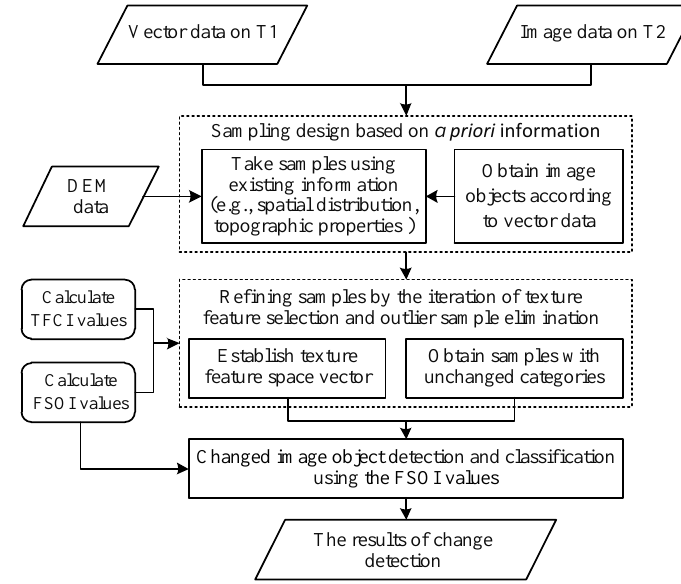
Figure 1. The framework of the proposed change detection approach.